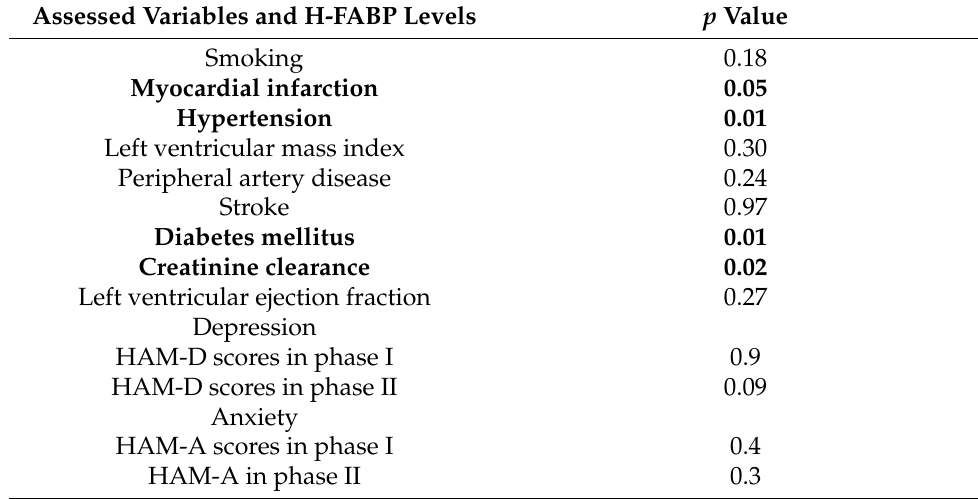
Table 7. Predictors for myocardial injury—univariate analysis ( N =